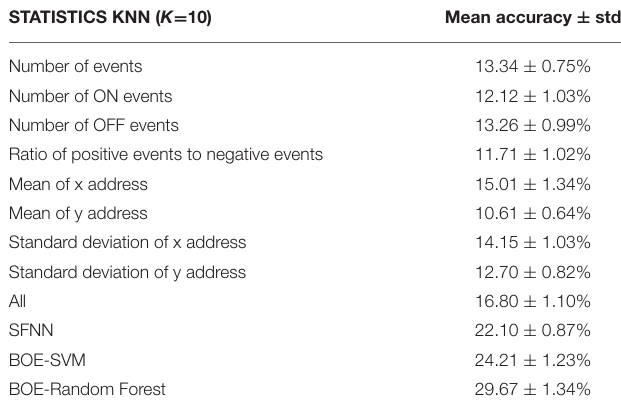
TABLE 4 | Classification accuracies for